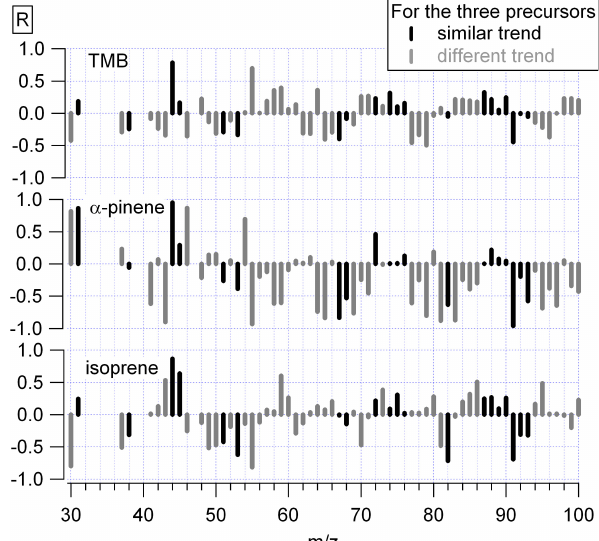
Fig. 4. Correlation analysis of the estimated κ org with f x (for m/z 30 to m/z 100) for the photooxidation experiments with different pre- cursors. Black bars indicate that the m/z had a similar sign for R for all precursors studied here. In contrast grey bars indicate that for one precursor R has a different sign compared to the other precur- sor for a same fragment.